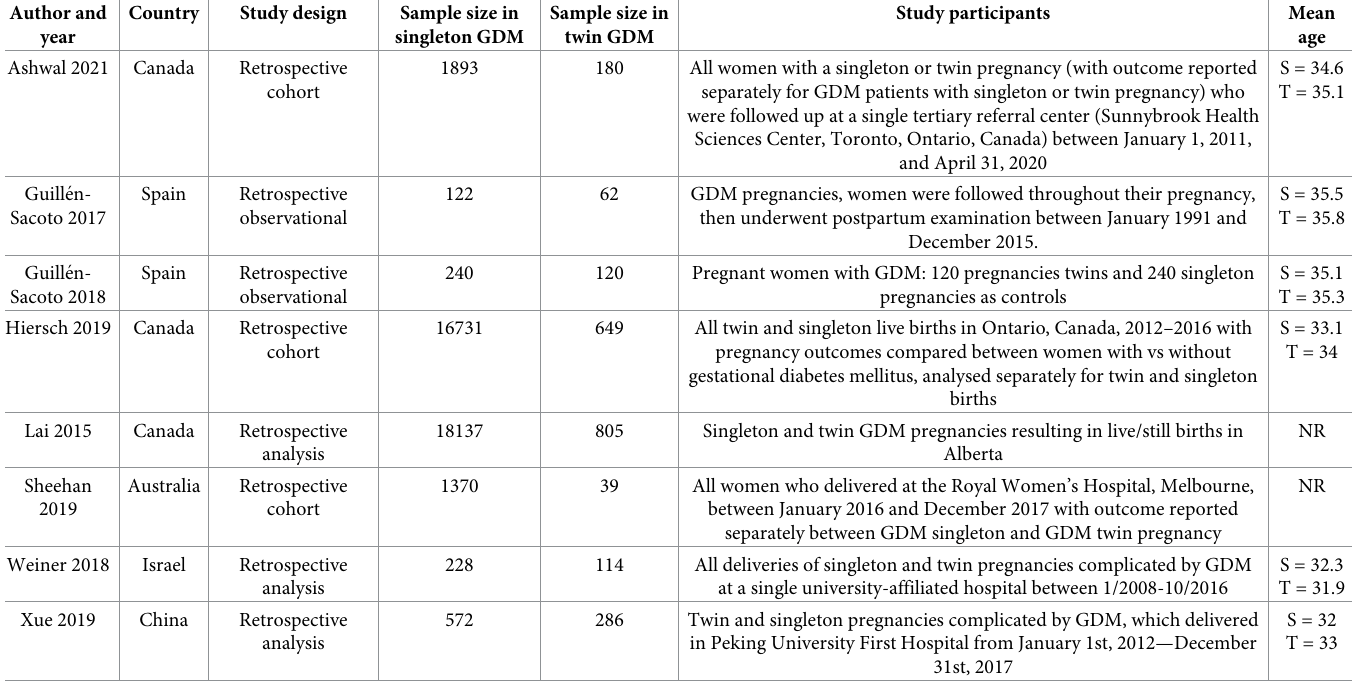
Table 1. Characteristics of the included studies (N = 8).